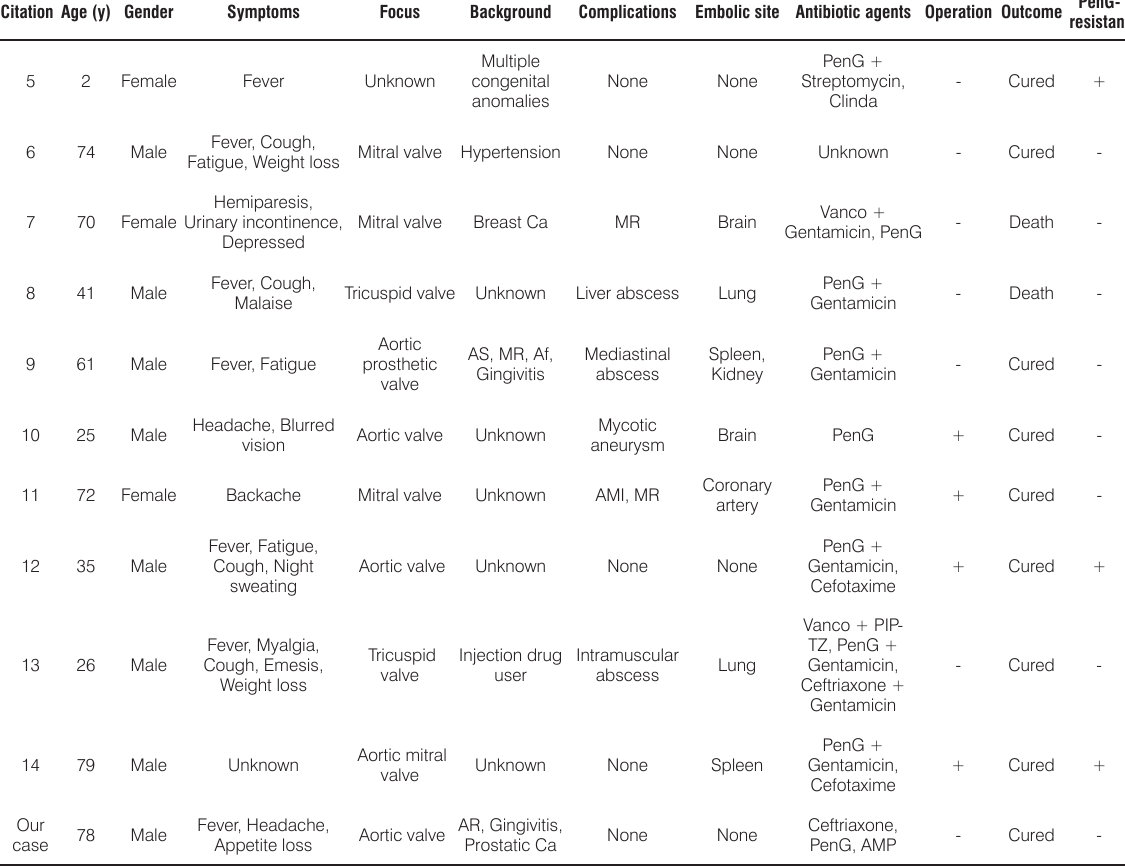
Table 1. Review of the literature, including the present